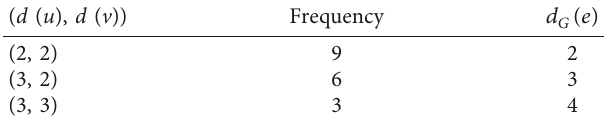
Figure 1: Jahangir graphs. Table 1: The single distance edge partition.